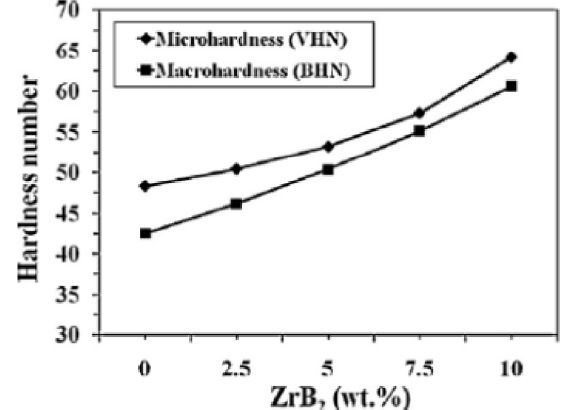
Fig. 2. Effect of weight percentage of ZrB hardness and macro hardness of